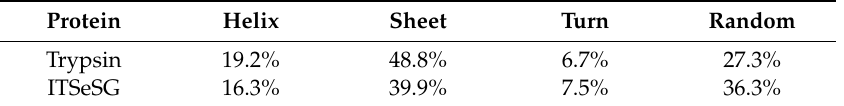
Protein Helix Sheet Turn Random Trypsin 19.2% 48.8% ITSeSG